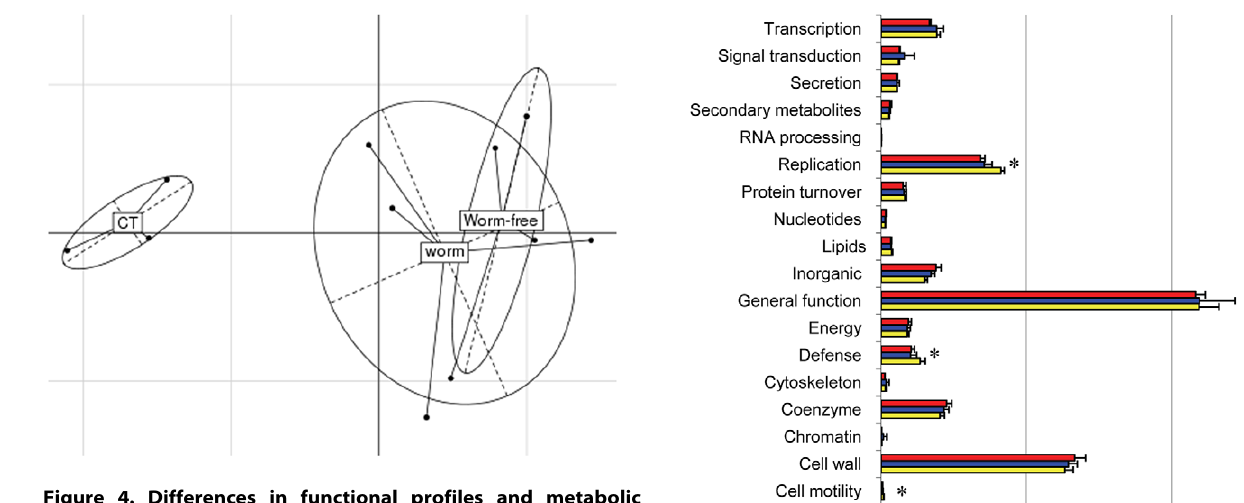
Figure 4. Differences in functional profiles and metabolic potentials of the porcine proximal colon microbiota between uninfected ( CT ) and infected groups ( Worm and Worm-free ) . Principal component analysis (PCA) was performed using the ade4 package in R based on relative abundance of 50 selected function classes assigned using the eggNOG database.